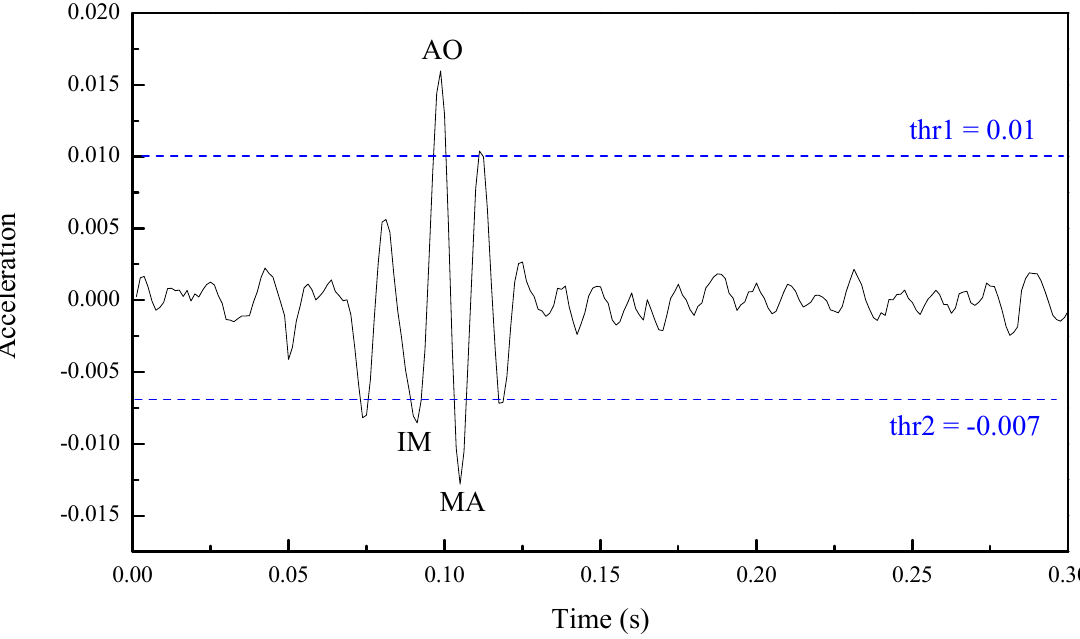
Figure 8. A correct aortic valve opening (AO) peak from a continuous 0.3s segment.